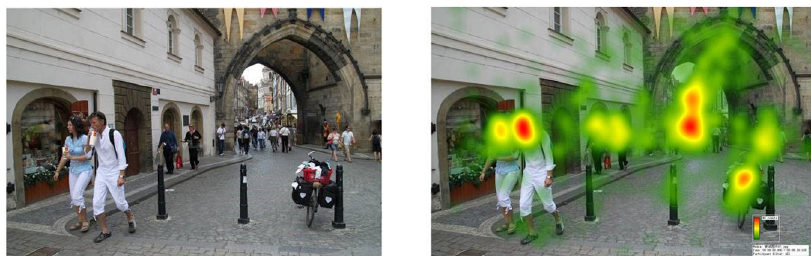
Fig. 12 The comparison of pedestrian 'zones' eye motion and